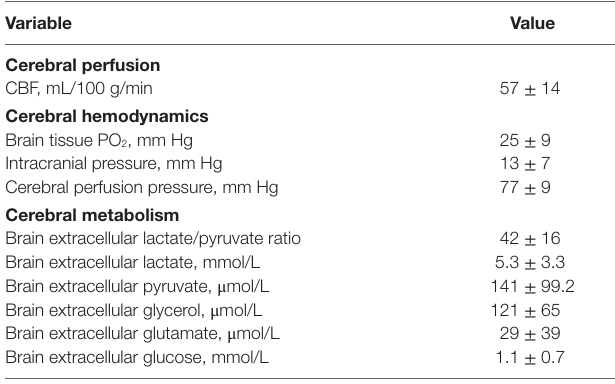
TaBle 2 | Global cerebral blood flow (CBF), main brain physiologic, and cerebral metabolic variables at the time of brain perfusion